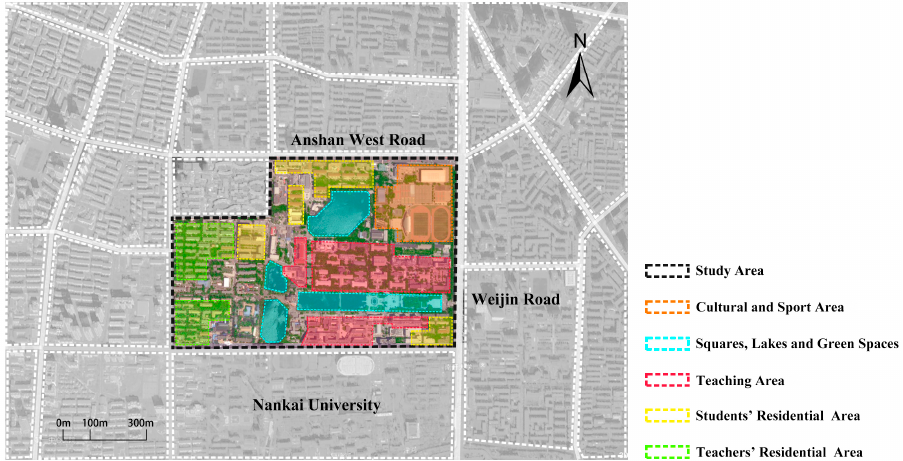
Figure 1. Functional analysis of the campus.